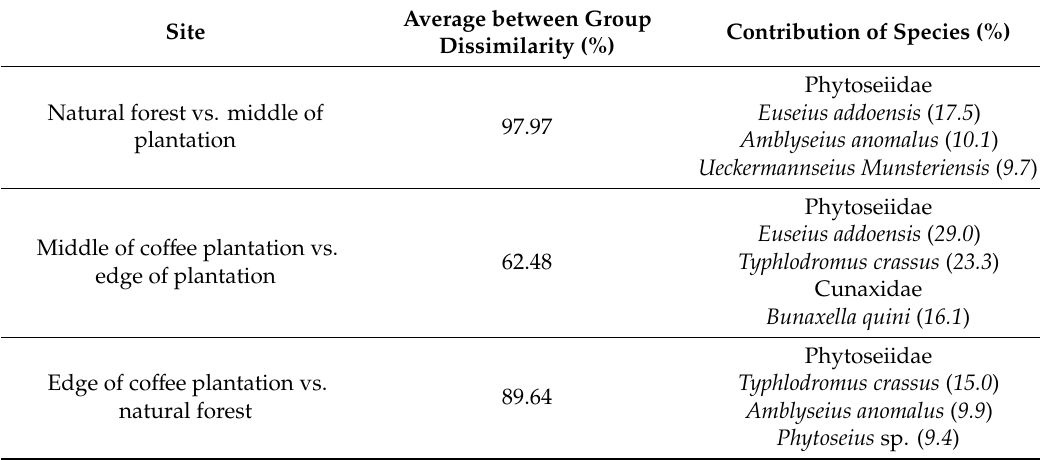
Table 3. The contribution of the mite species sampled to the average dissimilarity between the sampled